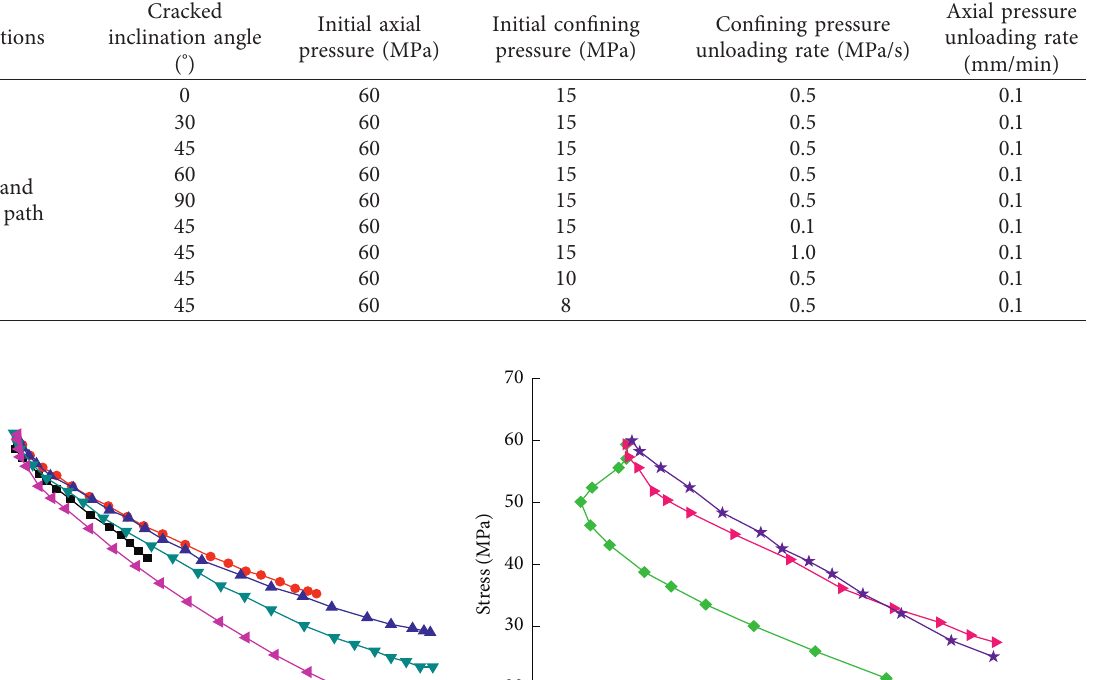
Table 1: Test project of cracked specimens under different axial unloading and radial unloading paths.